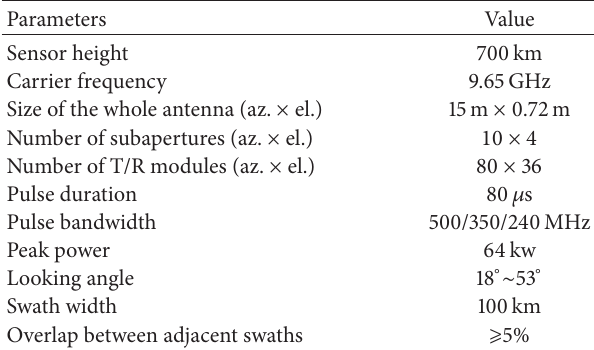
Table 1: Simulation system